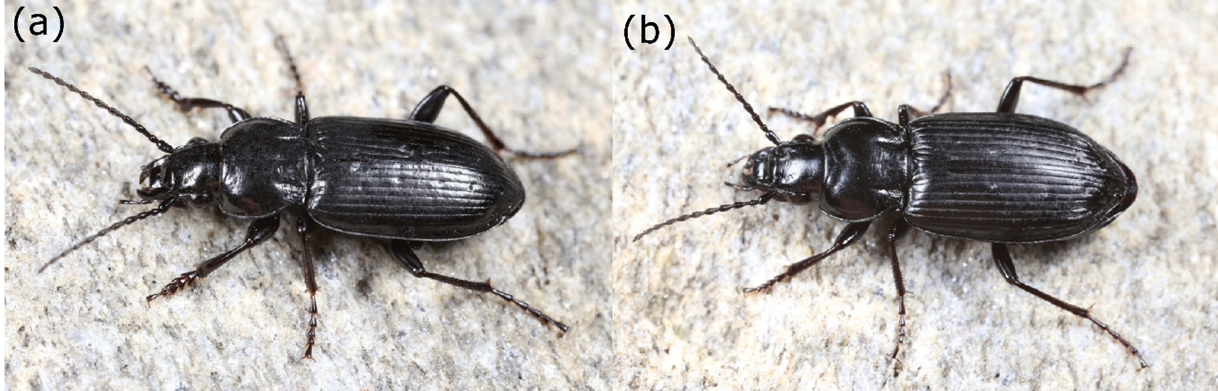
Figure 1. Habitus of male ( a ) and female ( b ) Pterostichus adstrictus from the Kaunertal (Ötztal Alps, Austria). The ratio of elytra length to the length of the pronotum was 2.62 ± 0.06 in the Austrian animals (Kaunertal: 2.62 ± 0.06, Taschachtal: 2.62 ± 0.06), but only 2.51 ± 0.06 in the